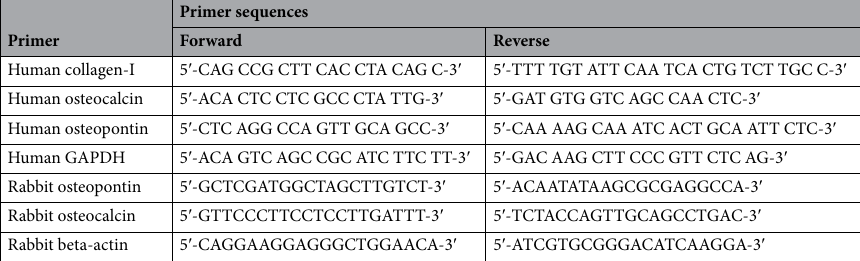
Table 1. List of primer sequences used for in vitro and in vivo osteogenic gene expression analysis.